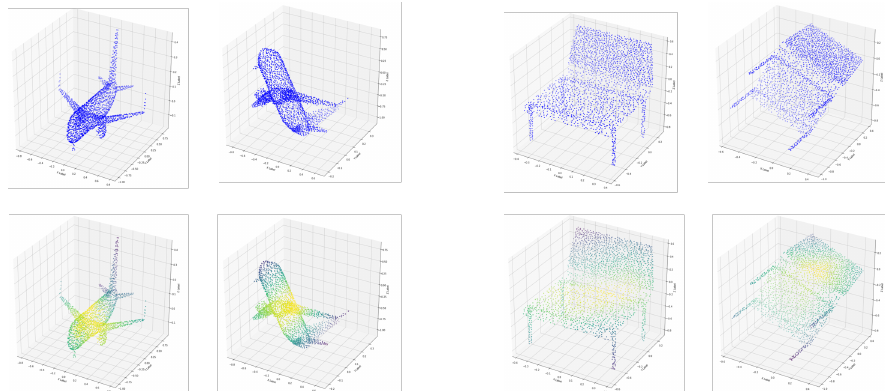
Figure 7. Visualization of rotated structures and attention masks. The first row are original and randomly rotated point sets. The second row are visualization of our generated attention masks respectively. The colors from dark to light correspond to the weights from 1 to